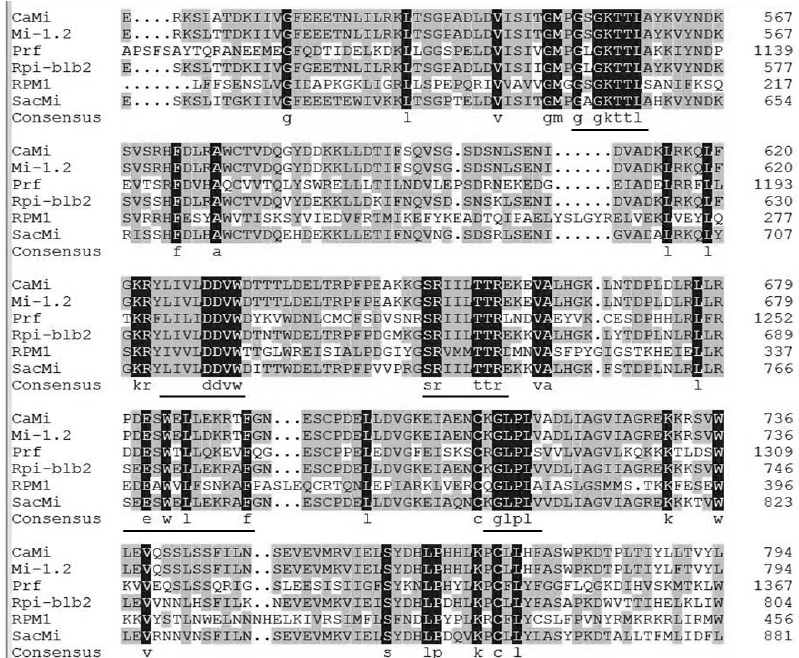
Figure 2. Multiple sequence alignments of the deduced amino acid sequence of SacMi and other R proteins, Mi-1.2 (AAC67238.1), CaMi (ABE68835.1), Prf (AAC49408.1), RPM1 (AGC12590.1), Rpi-blb2 (AAZ95005.1). Nucleotide-binding site (NBS) conserved domains are shaded and indicated by black lines. Black back ground, completely conserved region; Grey back ground, partly conserved region. To further understand the evolutionary relationships among SacMi and other plant resistance genes, including Solanum lycopersicum Mi-1.2 (AAC67238.1), Capsicum annuum CaMi (ABE68835.1), Solanum lycopersicum Prf (AAC49408.1), Solanum lycopersicum Hero (CAD29729.1), Arabidopsis